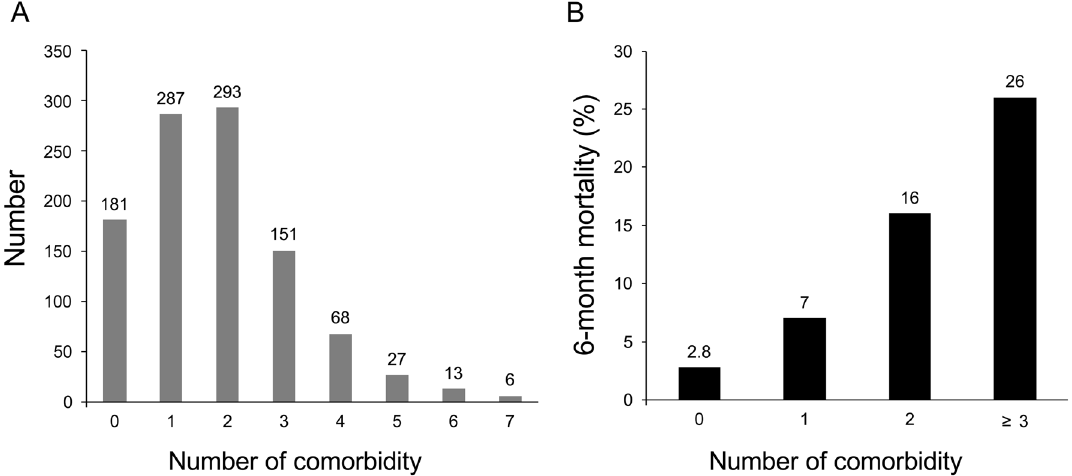
Figure 1. Frequency ( A ) and association of the number of comorbidities with 6-month mortality ( B ).